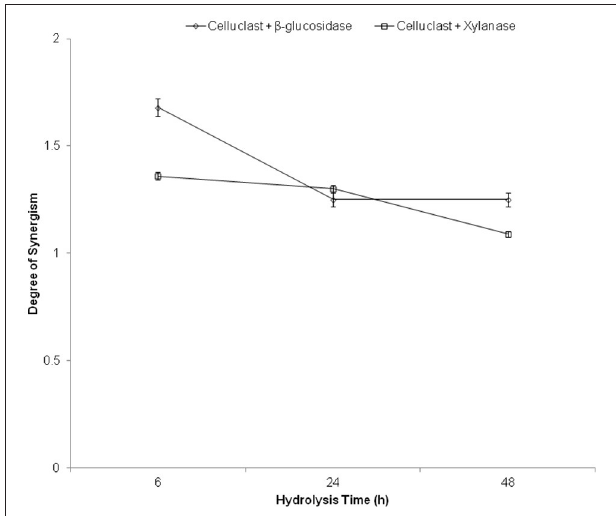
FIGURE 3 | Degree of synergism between Celluclast and accessory enzymes.